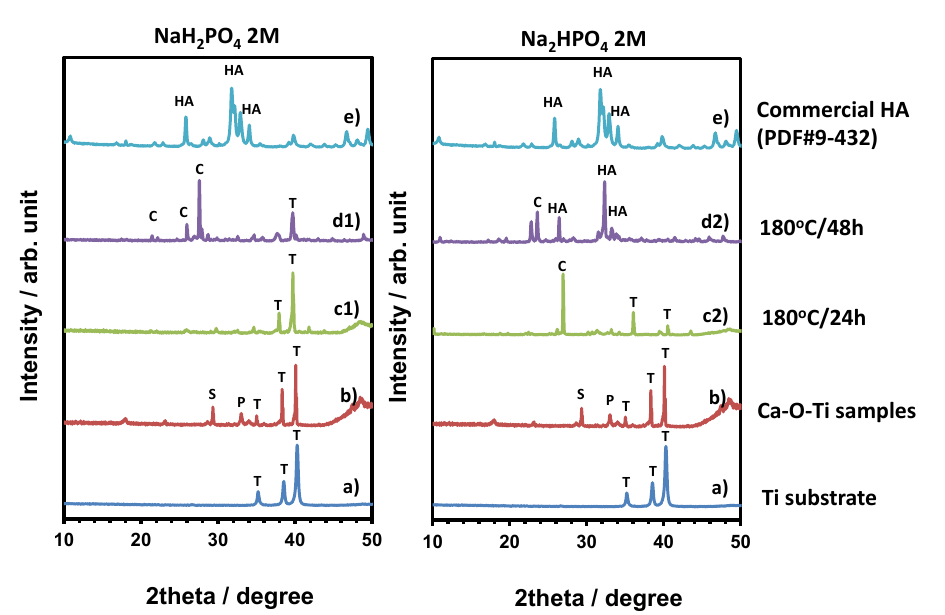
Figure 3. Thin film XRD patterns of ( a ) Ti bar; ( b ) Ca–O–Ti bar; and when hydrothermally treated with different phosphate solutions, such as ( c1 ) NaH 2 PO 4 2 M at 180 ◦ C for 24 h; ( c2 ) Na 2 HPO 4 2 M at 180 ◦ C for 24 h; ( d1 ) NaH 2 PO 4 2 M at 180 ◦ C for 48 h; ( d2 ) Na 2 HPO 4 2 M at 180 ◦ C for 48 h and ( e ) the commercial hydroxyapatite powder. Code: T—titanium (Ti) (PDF#44-1294); S—sodium hydrogen titanium oxide (Na 0.8 H 1.2 Ti 3 O 7 ) (PDF#48-0693); P—perovskite (CaTiO 3 ) (PDF#22-0153); C—cal- cium hydrogen phosphite (Ca(H 2 PO 2 ) 2 (PDF#01-0588); HA—hydroxyapatite (Ca 10 (PO 4 ) 6 (OH) 2 ) (PDF#09-0432).